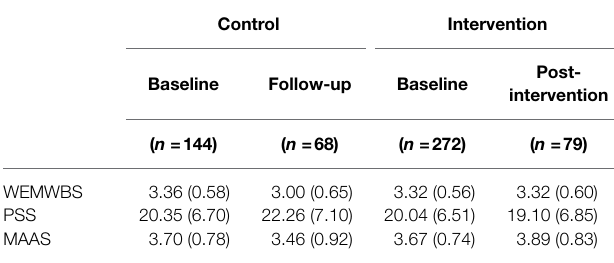
TABLE 2 | Outcome measures at baseline and post-intervention for the control and intervention